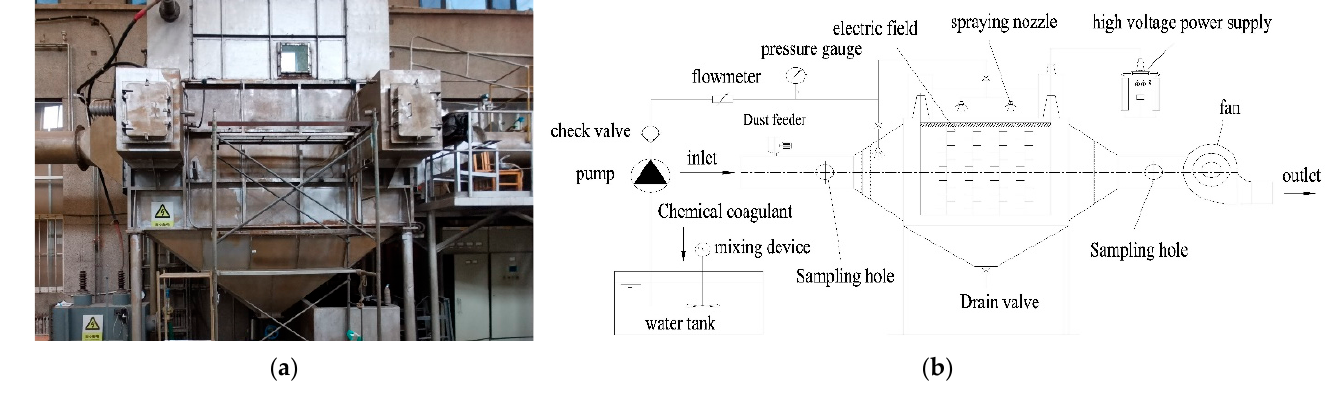
Figure 1. Wet electrostatic precipitator system. ( a ) is the field physical diagram of WESP. ( b ) is the internal structure of WESP.